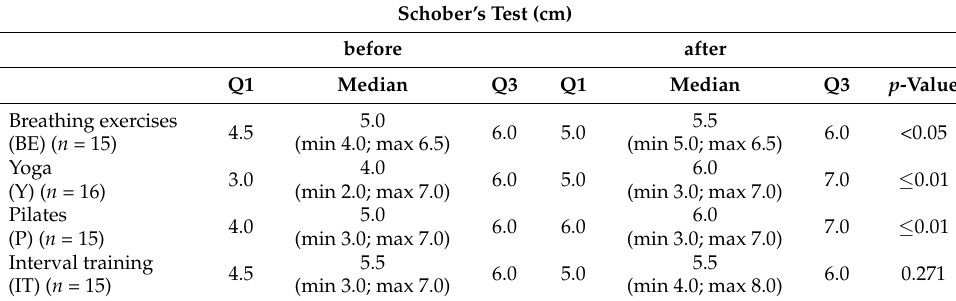
Table 3. Results of the Schober’s test (cm) of the four groups (target BE programme and three other programmes: yoga, Pilates and dynamic interval training) before and after the training period. The students participated voluntarily in and were randomly assigned to training programmes. The duration of each training session was one hour, twice a week for 7 weeks. Schober’s Test (cm)